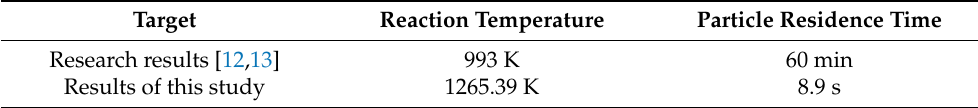
Table 9. Comparison of the results of this study with other research results. Target Reaction Temperature Particle Residence